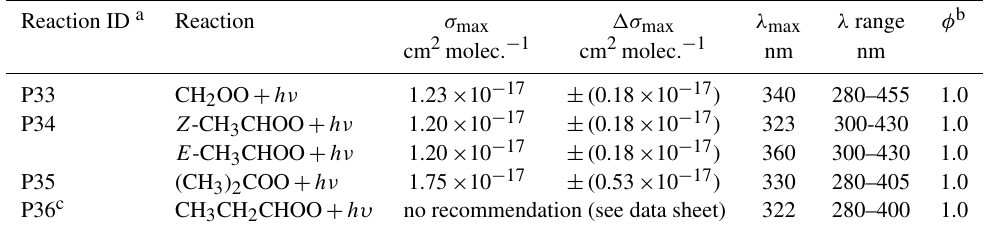
Table 4. Summary of the recommended spectral data for C 1 –C 3